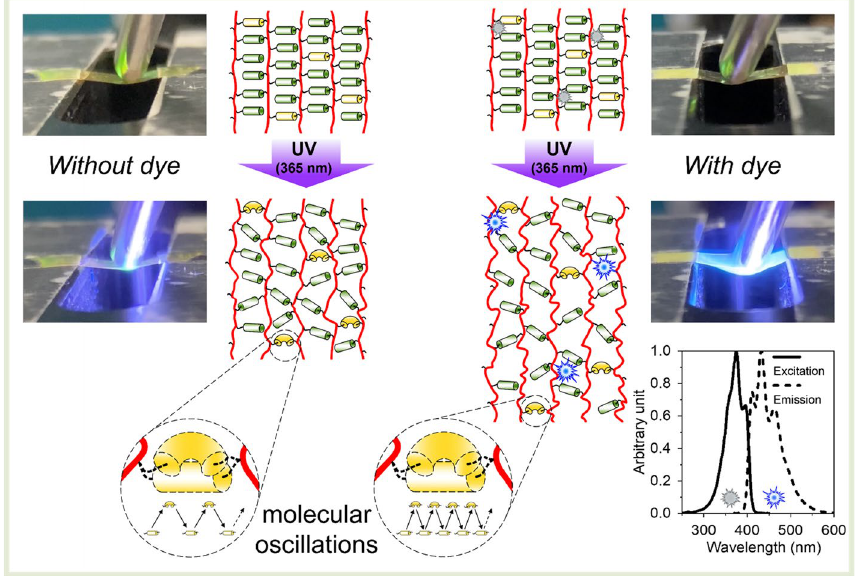
Figure 2. Amplification of photo-softening effect by incorporation of blue-emitting fluorescent dye (excitation and emission spectra are shown) in LCN structure. LCN films, containing azobenzene units (in yellow), connected from both sides to polyacrylate chains (in red) remain rigid in a normal state. Upon UV illumination of dye-free film, azobenzene units are predominantly in the cis state. The low oscillation frequency induces the moderate formation of free volume and softening of the material. During UV illumination of the dye-containing film, additional blue light emission results in simultaneous triggering of both the forward and backward isomerization reactions. This leads to a higher frequency of molecular oscillations and induces a larger free volume increase and change in material elasticity. For clarity, helicoidal structure of LCN is not shown. See supplementary video 1 for a real-life demonstration of the changing mechanical properties of the dye-containing material.